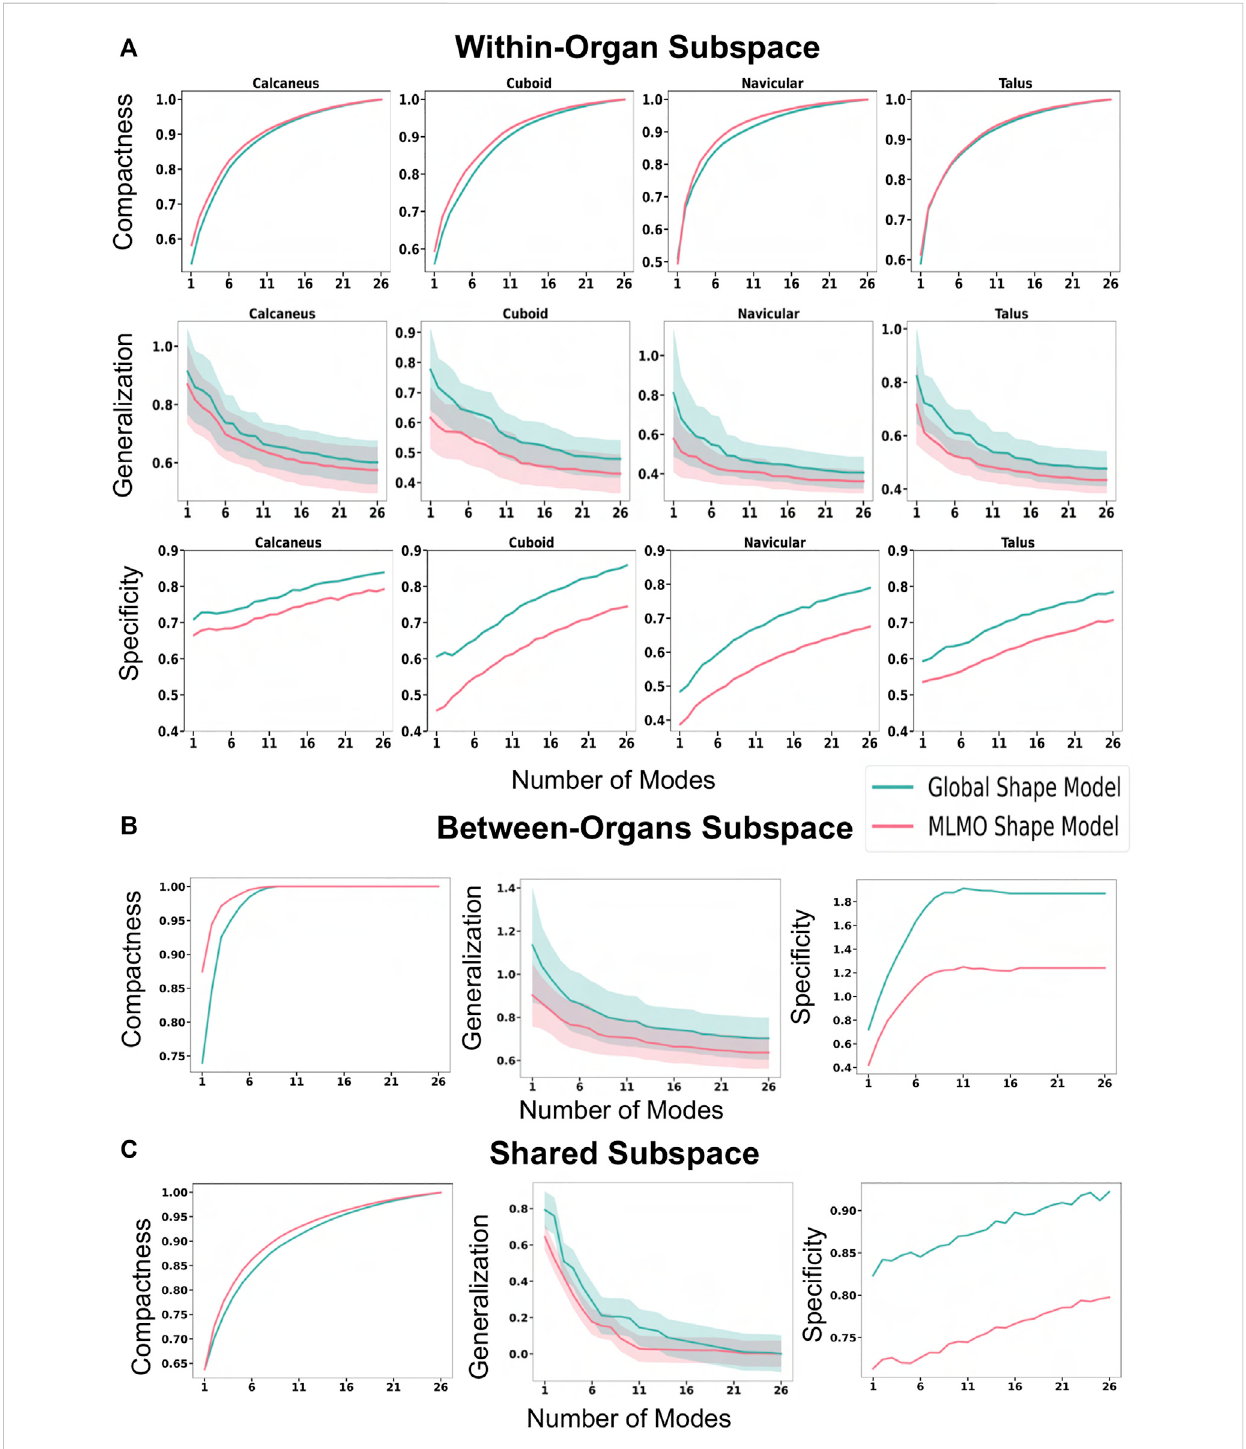
FIGURE 9 Quantitative Evaluation metrics (compactness, generalization (in mm ), and speci fi city (in mm )) for the foot and ankle dataset in (A) within-organ (B) between-organs (C) shared subspaces.